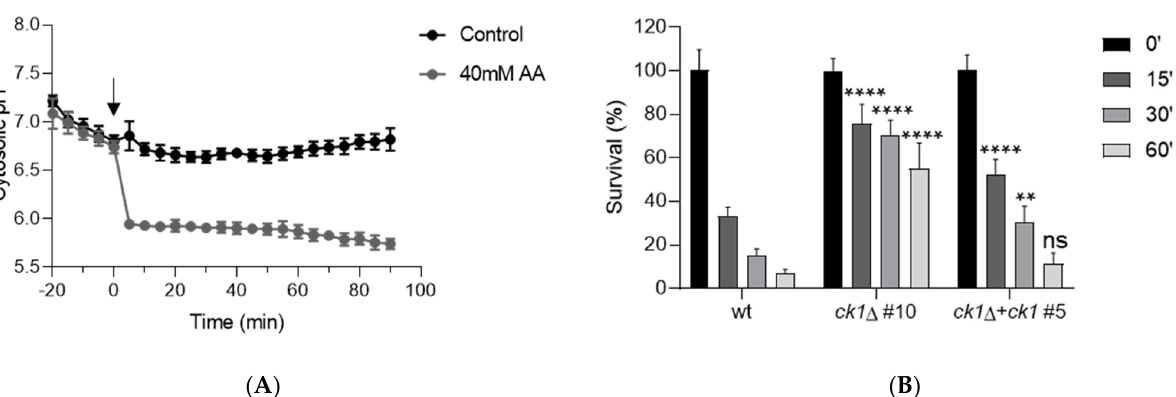
Figure 5. The ck1 ∆ mutant displays increased resistance to acetic acid-induced cell death. ( A ) The pH c was monitored in F. oxysporum wt germlings expressing pHluorin. Microconidia were germinated during 15 h in liquid PDB, germlings were washed and transferred to KSU buffered at pH 3.0, aliquoted into microwells and pre-incubated 60 min at 28 ◦ C before adding or not 40 mM acetic acid (AA). Samples were monitored spectrophluorometrically every 5 min starting 20 min before AA addition. pH c was calculated as the ratio between the emission intensities at 510 nm after excitation at 395 nm and 475 nm and normalized to the standard curve. Data show the mean and standard deviation from three replicate microwells from one representative experiment. Experiments were performed at least twice with similar results. ( B ) Microconidia of the indicated strains were germinated during 15 h in PDB, then the pH of the medium was adjusted to 3.0 with diluted HCl and germlings were pre-incubated for 1 h at 28 ◦ C before adding 0.4 mM AA. Germlings collected before (time 0) or at the indicated times after AA addition (min) were diluted and plated on complete medium plates. After two days of incubation at 28 ◦ C, the number of colonies was counted, and survival was calculated. p < 0.0001(****), p < 0.001 (**), ns, not significant versus wt according to two-way ANOVA and Bonferroni Test. Bars show the mean and standard deviation from three independent biological experiments.